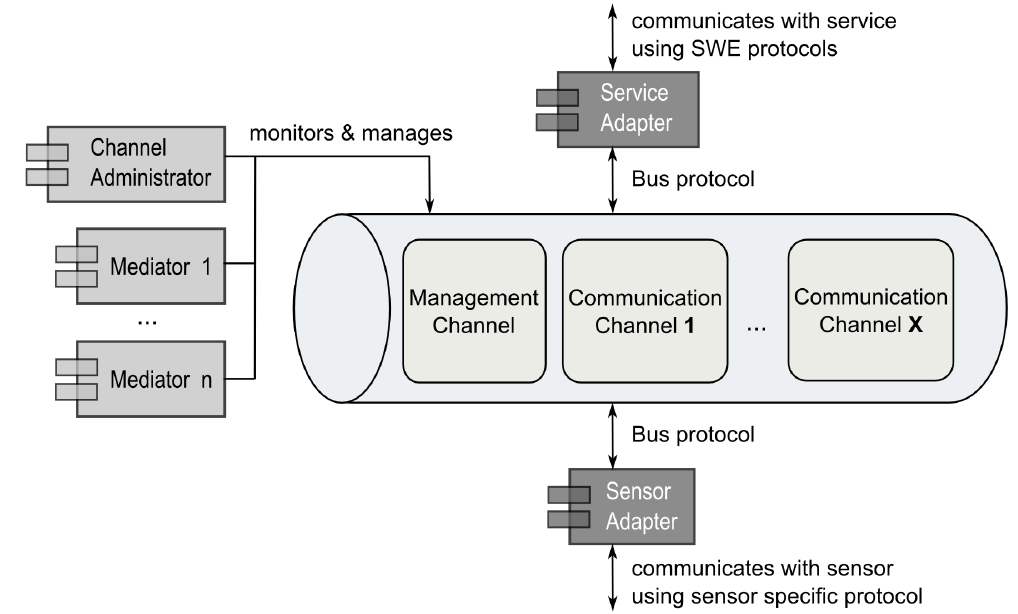
Figure 6. Components of the Sensor